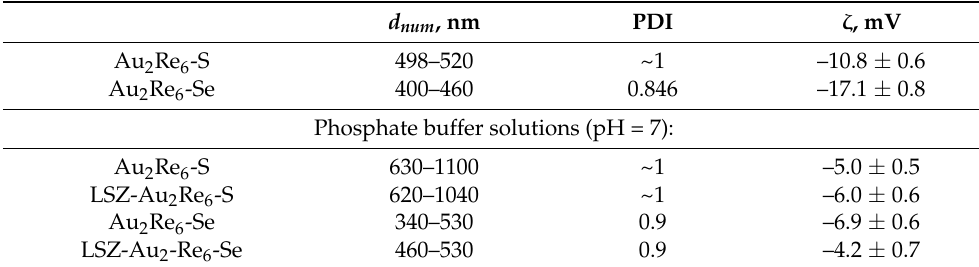
Table 1. Evaluated through the size distribution by number ( d num ) diameter values, polydispersity indices (PDI), and electrokinetic potentials ( ζ ) of Au 2 Re 6 -Q colloids both itself and after the addition of lysozyme (LSZ) (1.6 µ M). Concentration of phosphate buffer is 0.01 M. d num ,